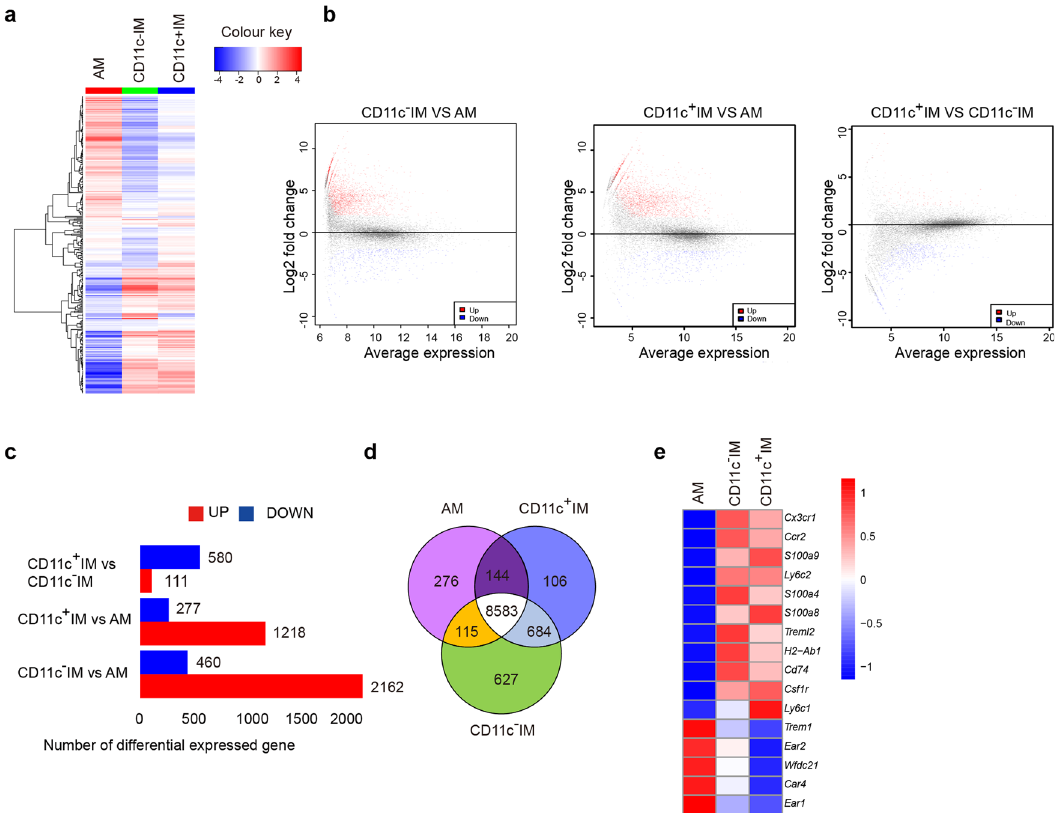
Fig. 3 Transcriptional signature of lung macrophages in tumor environment. a – e RNA-Seq analysis on macrophage populations isolated by FACS-sorting from entire lungs of B16 tumor bearing mice. The lungs were perfused and isolated from tumor-bearing mice. a , b Differential gene expression in WT AMs, CD11c + IMs and CD11c − IMs derived from unsupervised clustering. c Numbers of differentially expressed genes among WT AMs, CD11c + IMs and CD11c − IMs. d Venn diagram showing the overlap of genes expressed among AMs, CD11c − IMs, and CD11c + IMs. e Heatmap showing gene expression in macrophage